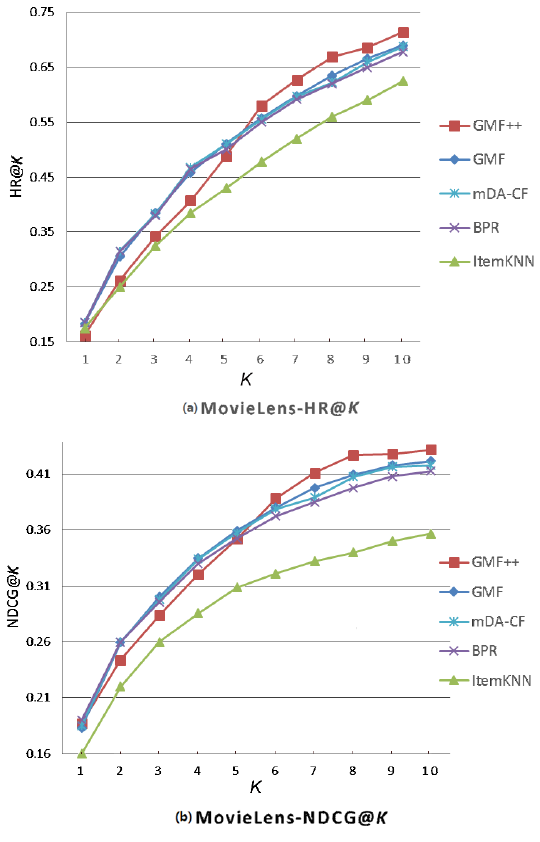
Performances of HR@ K and NDCG@ K w.r.t. K .